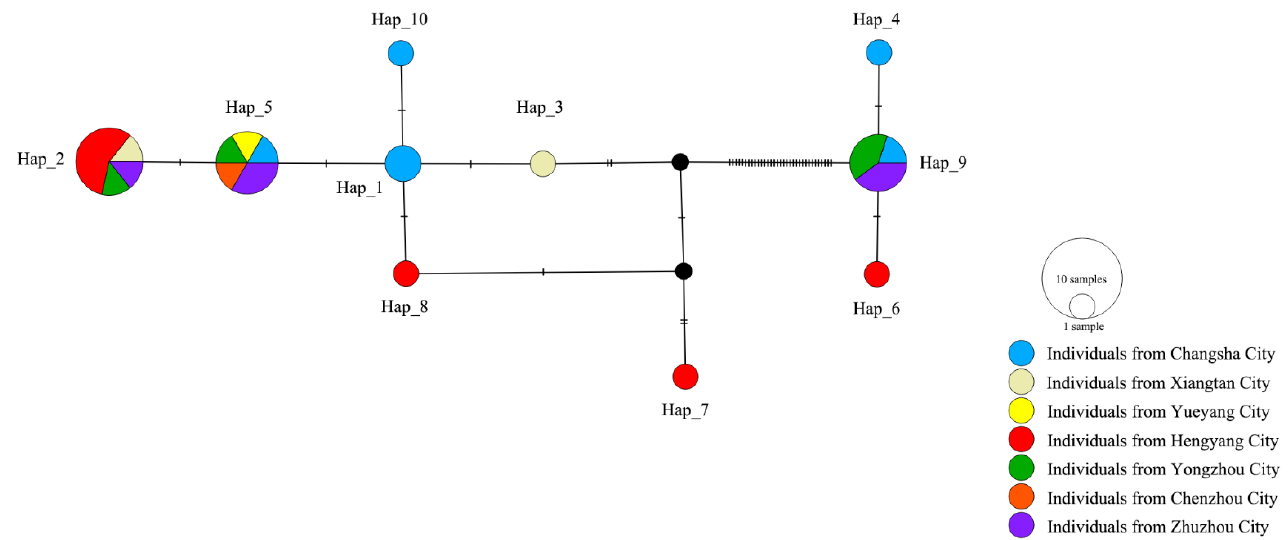
Figure 3. Unrooted network of 10 haplotypes in 39 individuals of M. remanens from 7 locations, based on 617 bp of COI gene. Each circle in the haplotype network is homologous with one haplotype, and its size is proportional to its frequency among samples. Dark dots represent intermediate haplotypes that were not sampled or died out. Table 3. Summaries of genetic diversity measurement and neutrality tests, based on the COI + COII + 12S + 16S + ND1